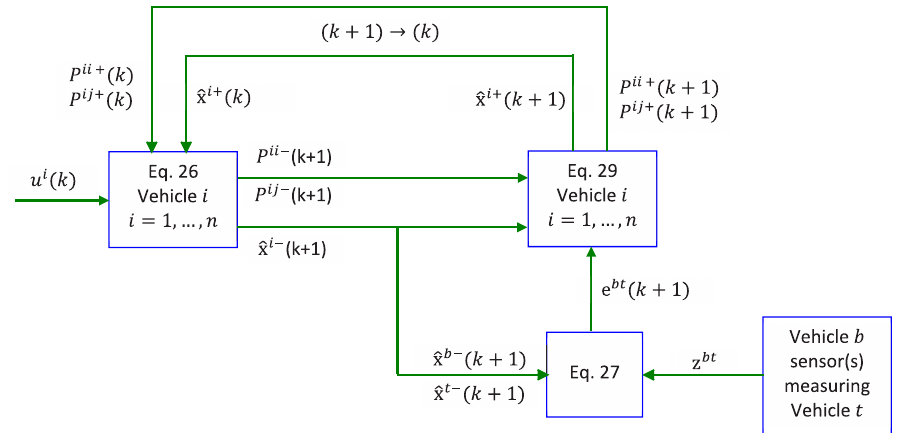
Figure 3. Centralized EKF-based CL